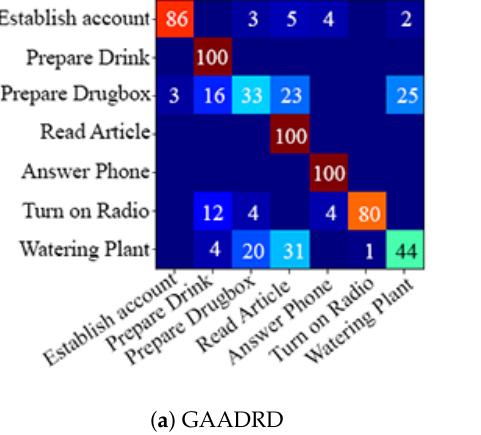
Figure 10. Confusion matrices regarding the best configuration of the unsupervised framework on ( a ) GAADRD and ( b ) CHU datasets (with Motion Boundaries Histogram in Y axis (MBHY) descriptor). The values show mean accuracy